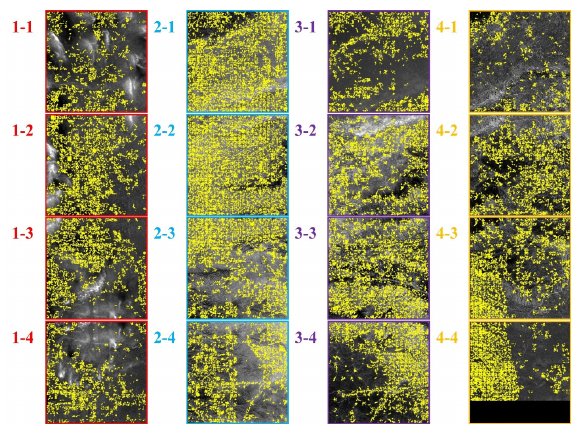
Figure 1 Distributions of the image and ground control points -line-array CCD camera, a 2-meter-resolution full-color camera, and a 10-meter-resolution multispectral camera. Three-line imagery can be used for topographic mapping at the 1:50000 scale. The experiments used four groups of three-line array nadir-viewing images taken in November 2010, November 2012, April 2013, and May 2014. Each dataset contains 4 scenes of the same-track image and corresponding RPC data. The 2-meter-resolution aerial orthophoto of the corresponding area as the reference data and use the AW3D30 data to obtain the corresponding ground point elevation data. A variety of matching algorithms were used to automatically match satellite and aerial DOM imagery data to obtain a total of 171,106 ground control points, the distribution of which is shown in Figure 1. The background image in Figure 1 is the original satellite image. From left to right: the first dataset (2010); the second dataset (2012); the third dataset (2013); the fourth dataset (2014). The yellow dots indicate the distribution of the ground control points extracted automatically. The numbers on the left side of the image are the image numbers. The upper and lower overlap between the same-track images in each dataset is 20%. Among them, image 4-4 is nonstandard scene data, and there are no data for approximately 2,000 lines, but these missing data not affect the RPC accuracy evaluation experiment. As seen from Figure 1, except for the cloud occlusion area in the image, the number of ground control points is sufficient, and the distribution is relatively uniform, which can meet the requirements of RPC correction and accuracy evaluation.